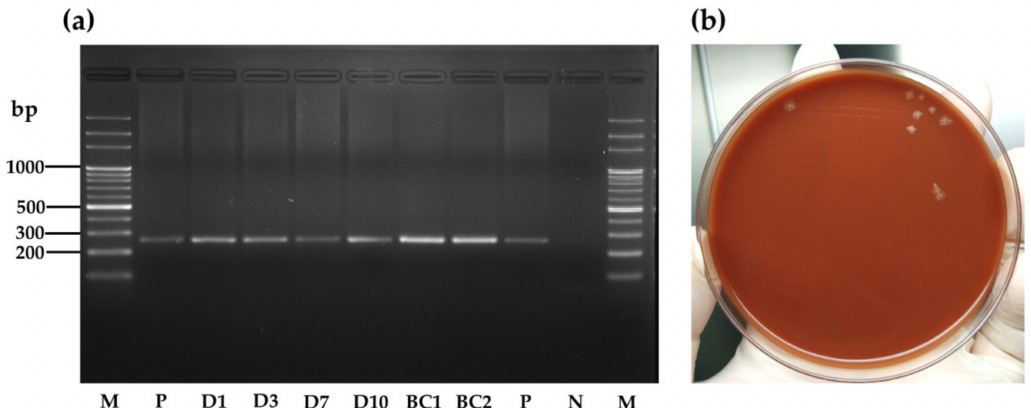
Figure 3. Detection of B. henselae by nested PCR ( a ) and culture ( b ) from fecal samples collected on day 14 and incubated for 1 day after R. sanguineus s.l. adult tick feeding on B. henselae -infected blood through artificial membrane feeding system. M, DNA marker; D1, fecal sample collected on day 14 and incubated for 1 day; D3, fecal sample collected on day 14 and incubated for 3 days; D7, fecal sample collected on day 14 and incubated for 7 days; D10, fecal sample collected on day 14 and incubated for 10 days; BC1 and BC2, bacterial colonies isolated from feces collected on day 14 and incubated for 1 day; P, positive control ( B. henselae DNA); N, negative control (distilled